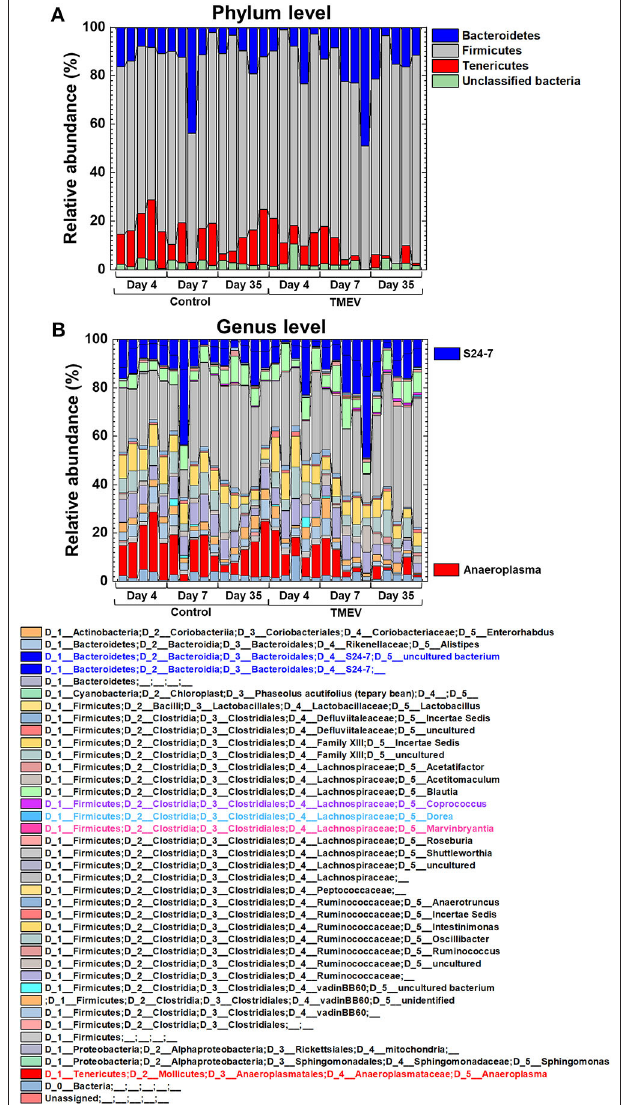
FIGURE 4 | Relative abundance of fecal bacteria in the TMEV-infected and control groups. Fecal DNA was extracted and analyzed the microbiome by 16S rRNA sequencing. (A) At the phylum level, Bacteroidetes (blue) and Tenericutes (red) seemed to be increased and decreased in the TMEV-infected groups, respectively, without statistical differences. (B) At the genus level, on day 35, two taxa of the family S24-7 (blue) and the genus Anaeroplasma (red) seemed to be increased and decreased in the TMEV-infected group, respectively, without statistical differences.